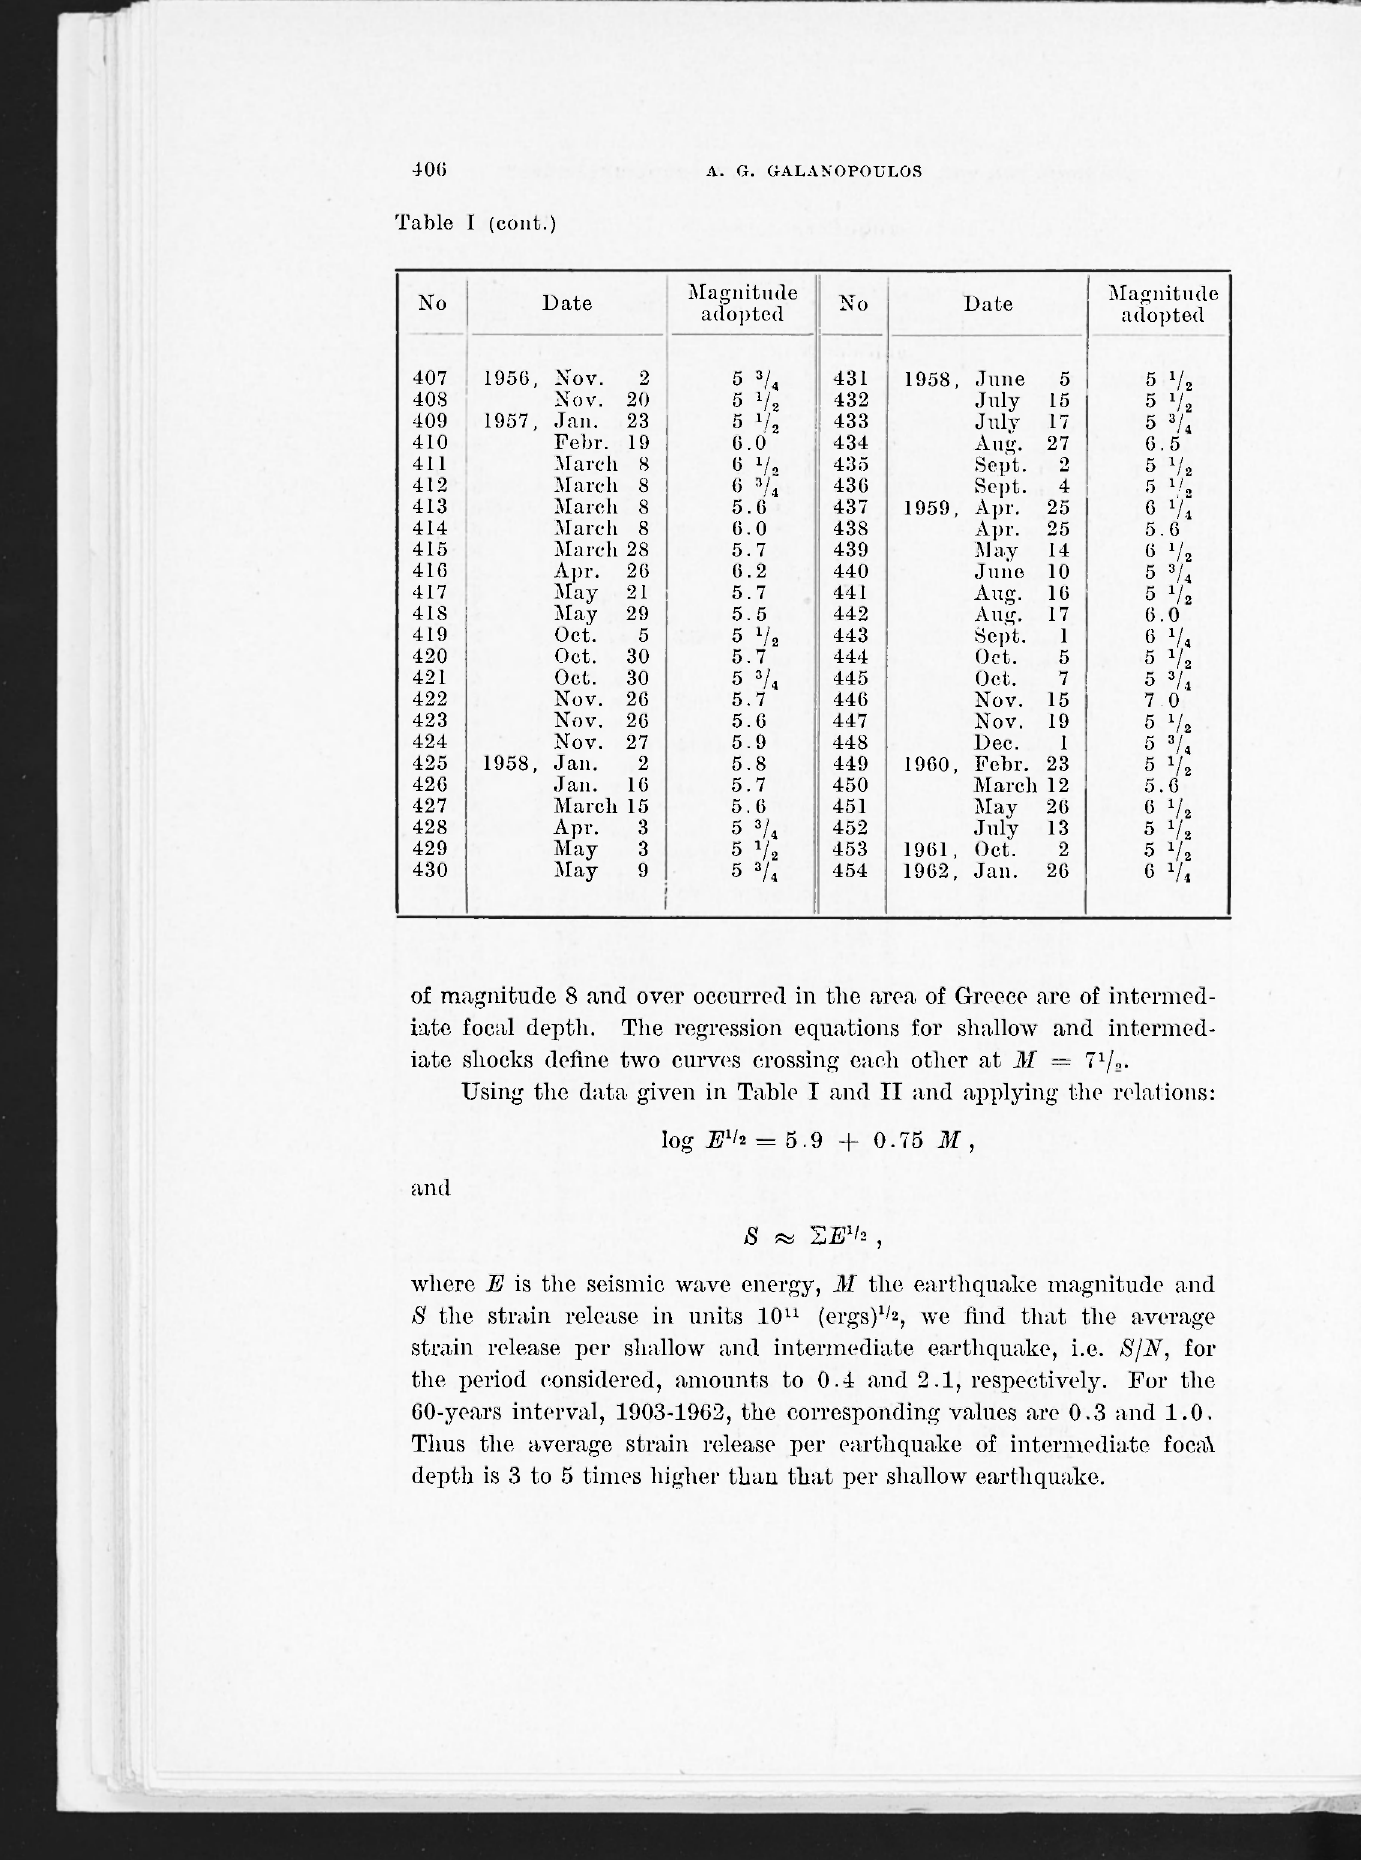
strain release per shallow and intermediate earthquake, i.e. 8/N,